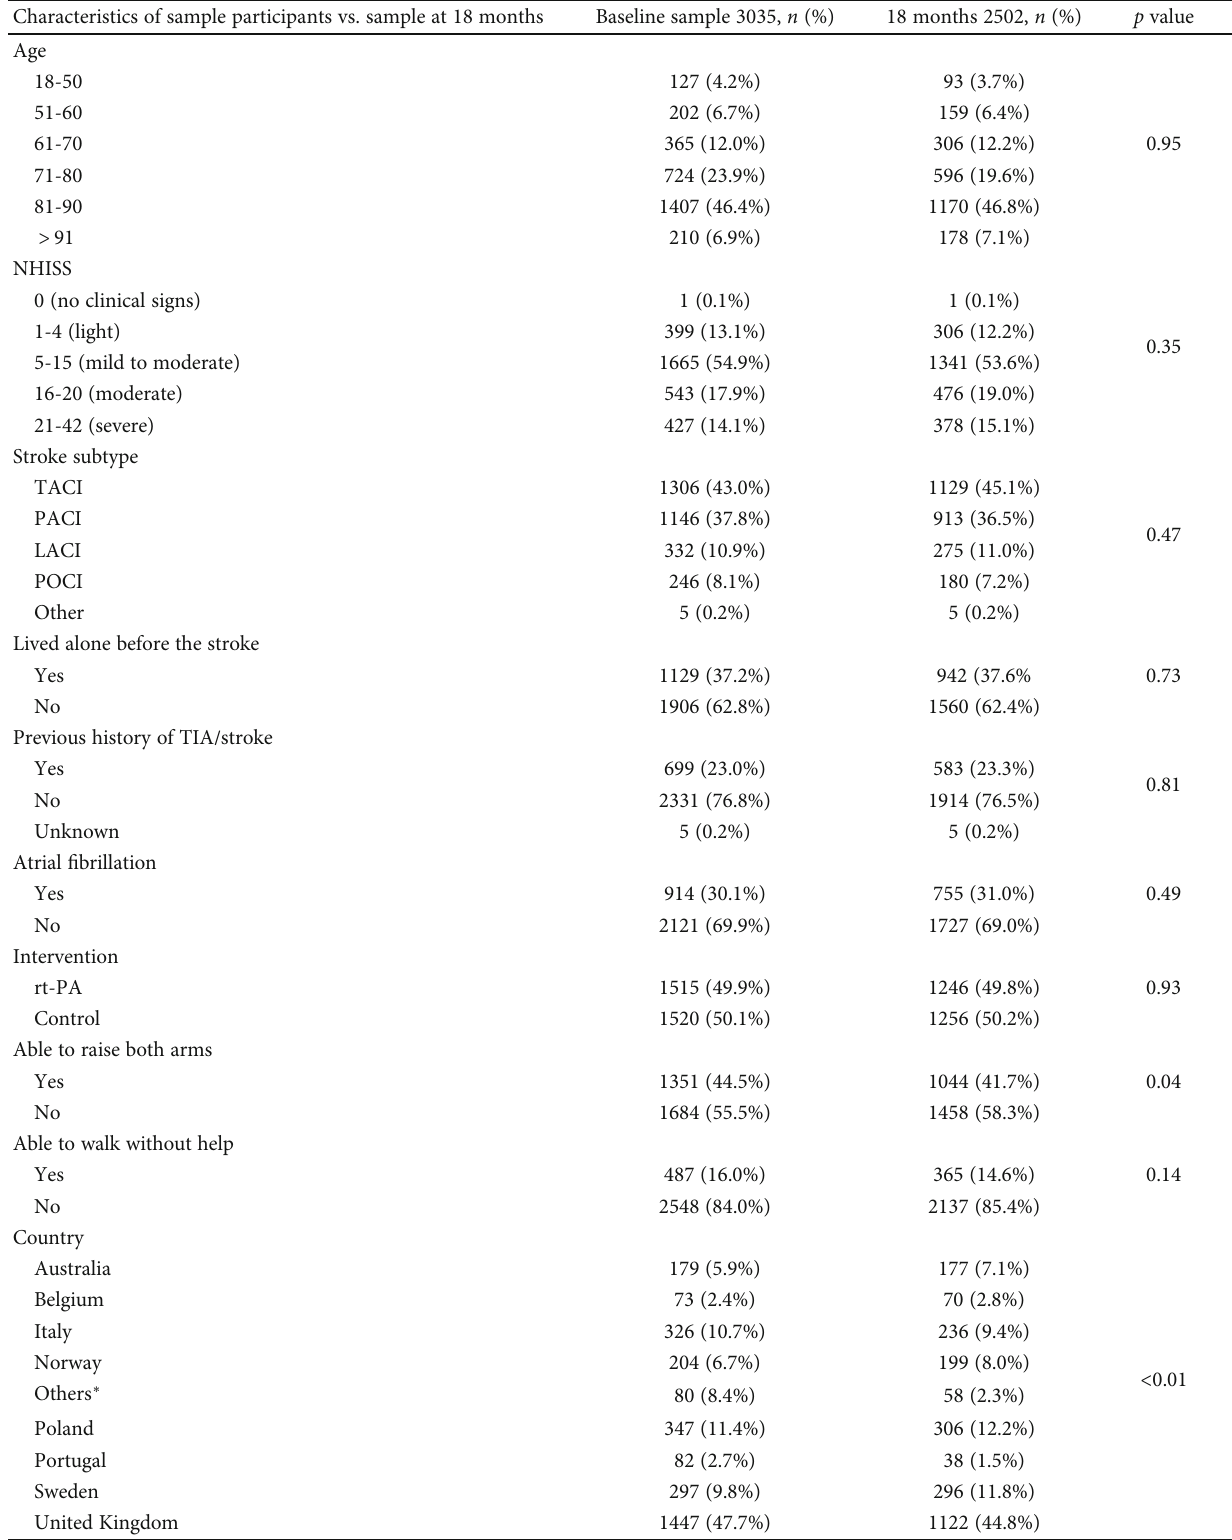
Characteristics of sample participants vs. sample at 18